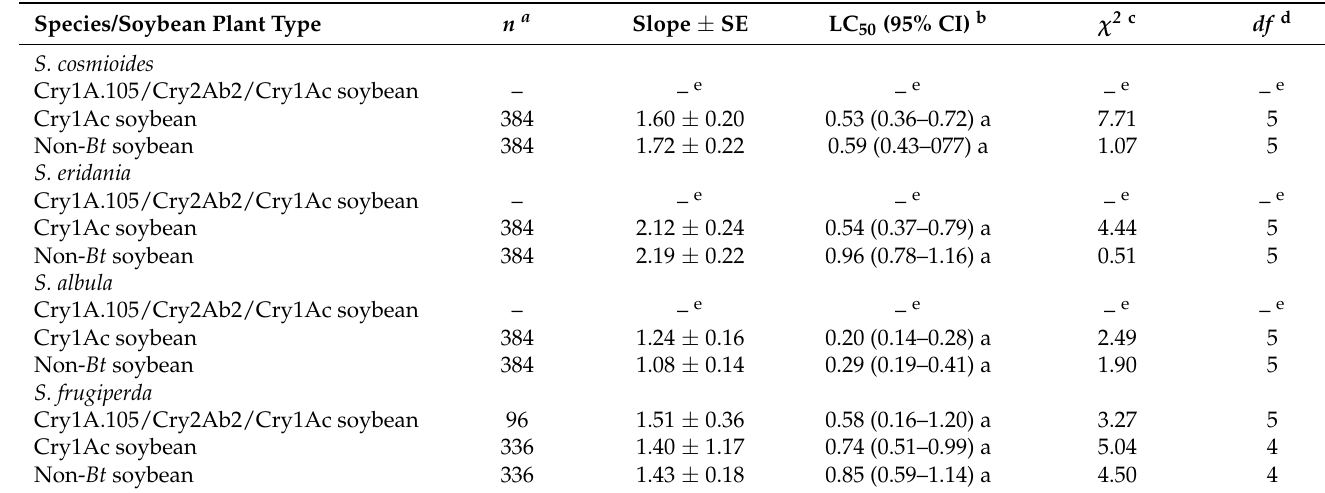
Table 3. Concentration–mortality response to flubendiamide by Spodoptera species developing on Bt and non- Bt soybean in laboratory